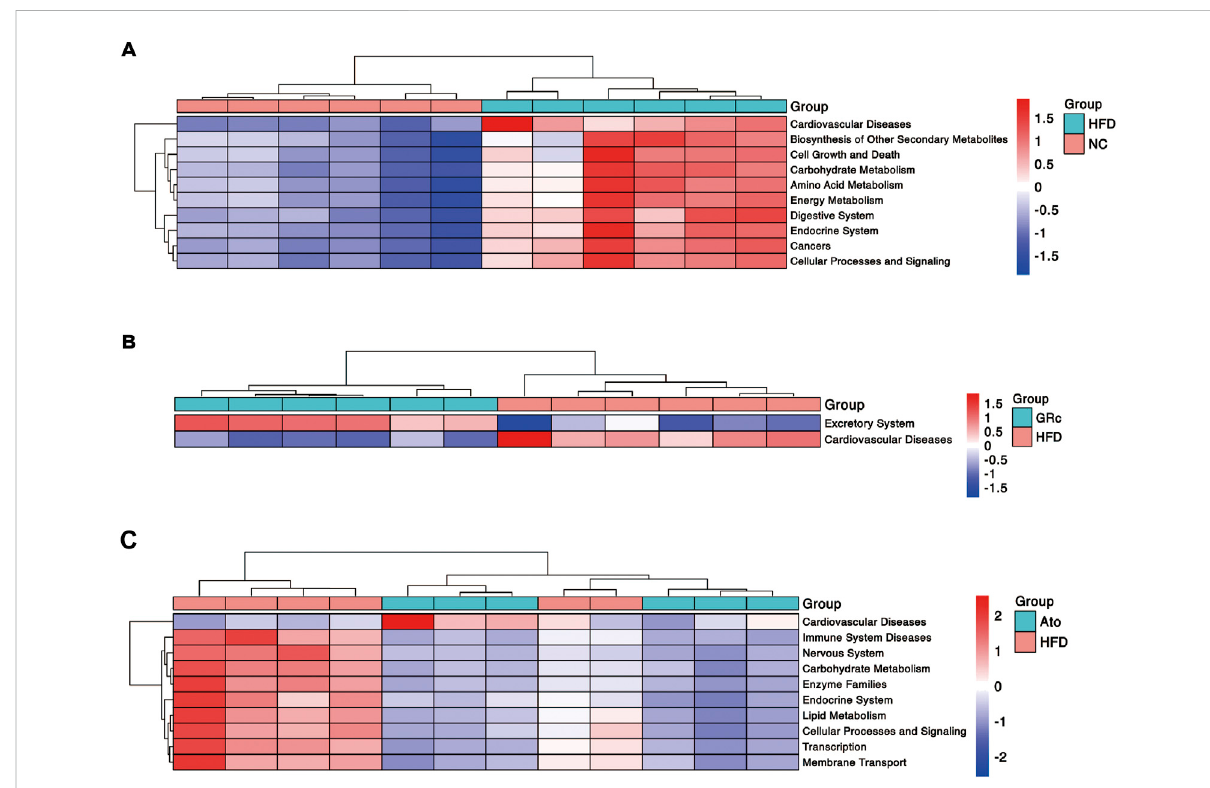
FIGURE 6 Predictive functional pro fi ling of microbial communities by PICRUSt2 ( n = 6). (A) Differences in intestinal microbiome functional pro fi ling betweenHFDandNCgroups. (B) Differencesinintestinalmicrobiomefunctionalpro fi lingbetweenGRcandHFDgroups. (C)